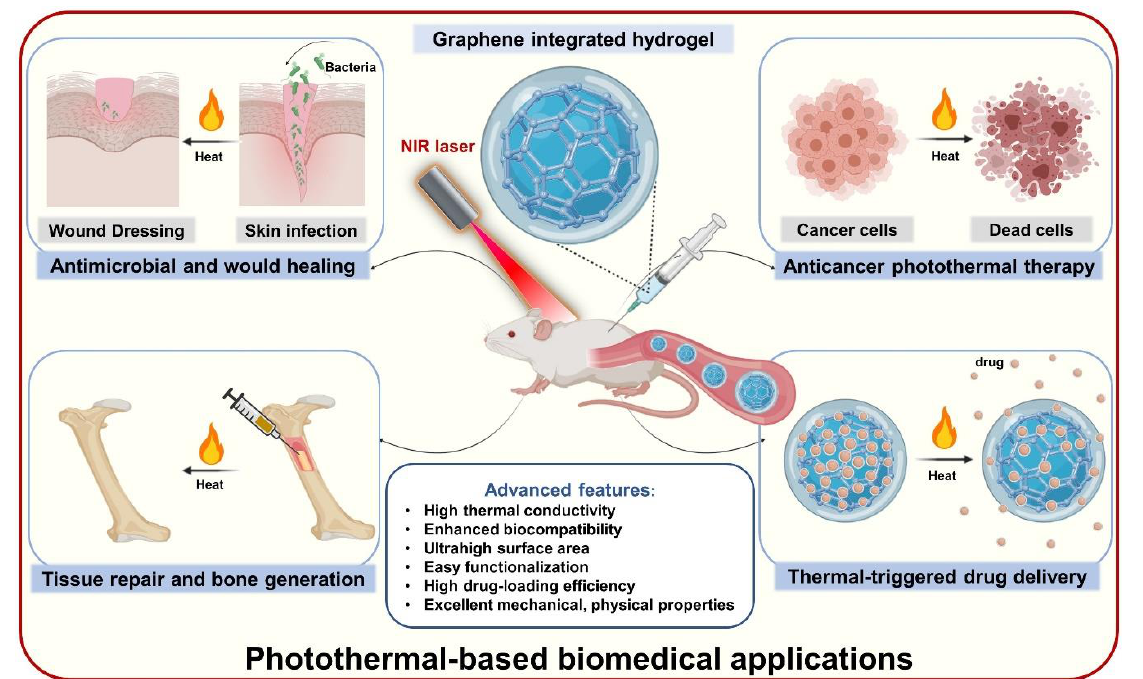
Figure 1. General illustration of advanced features and applications of graphene-based hydrogels as promising photothermal agents in diverse PTT-based biomedical fields, including anticancer photothermal therapy, thermal-triggered drug delivery, antimicrobial activity, wound healing acceleration, tissue repair and bone generation.